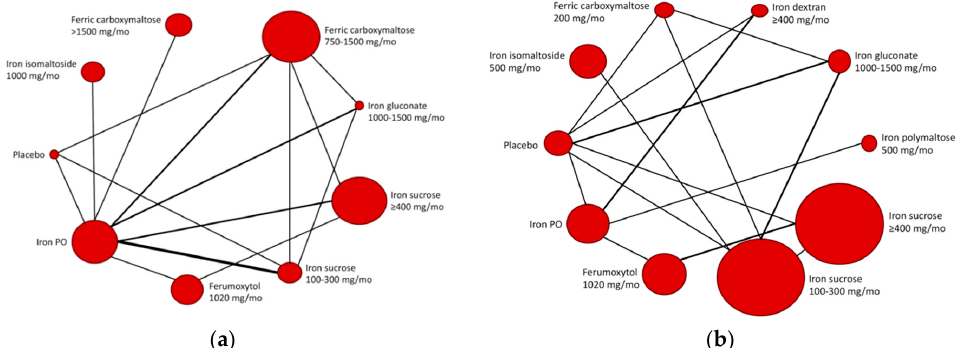
Figure 3. Bayesian network diagrams presenting the density in the comparisons (thickness of lines according to the number of RCTs in each comparison) and the competing iron supplements (node size according to the number of participants undergoing interventions) for the subgroups of ( a ) patients in the KDIGO GFR categories 3A to 5, and; ( b ) dialysis patients. GFR, Glomerular filtration rate; KDIGO, Kidney Disease—Improving Global Outcomes; RCT, randomized controlled trial.